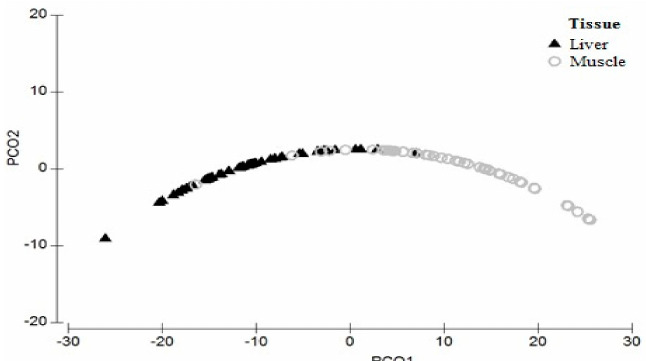
Figure 2. Principal coordinates analysis (PCO) of THg concentration (ng g − 1 ) in the liver (black triangle) and muscle (grey circle) of Podocnemis